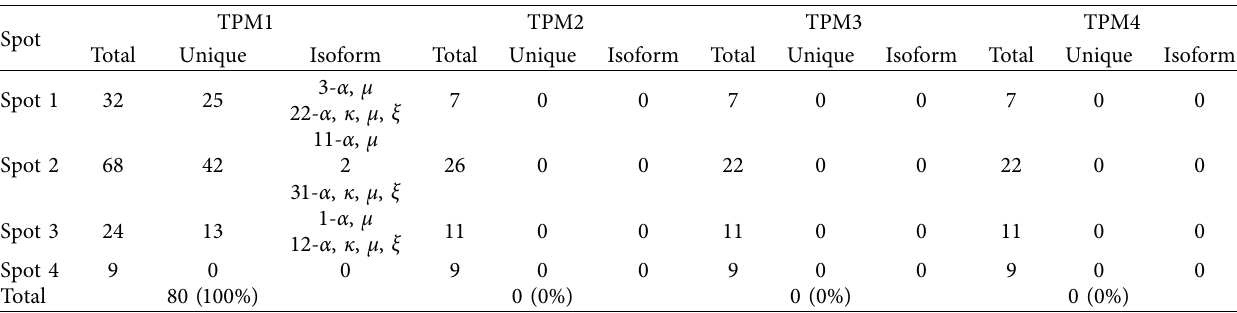
Figure 8: Relative and absolute expression of TPM4 α in Cyn striated muscles. (a) Relative expression of TPM4 α using the dCt method in the Cyn heart and skeletal muscle. (b) Fold change of TPM4 α in the Cyn heart and skeletal muscle using the ddCt method. (c) Determination of the absolute copy number of TPM4a in the Cyn heart and skeletal muscle. Table 3: Tropomyosin peptides identifed in adult monkey heart